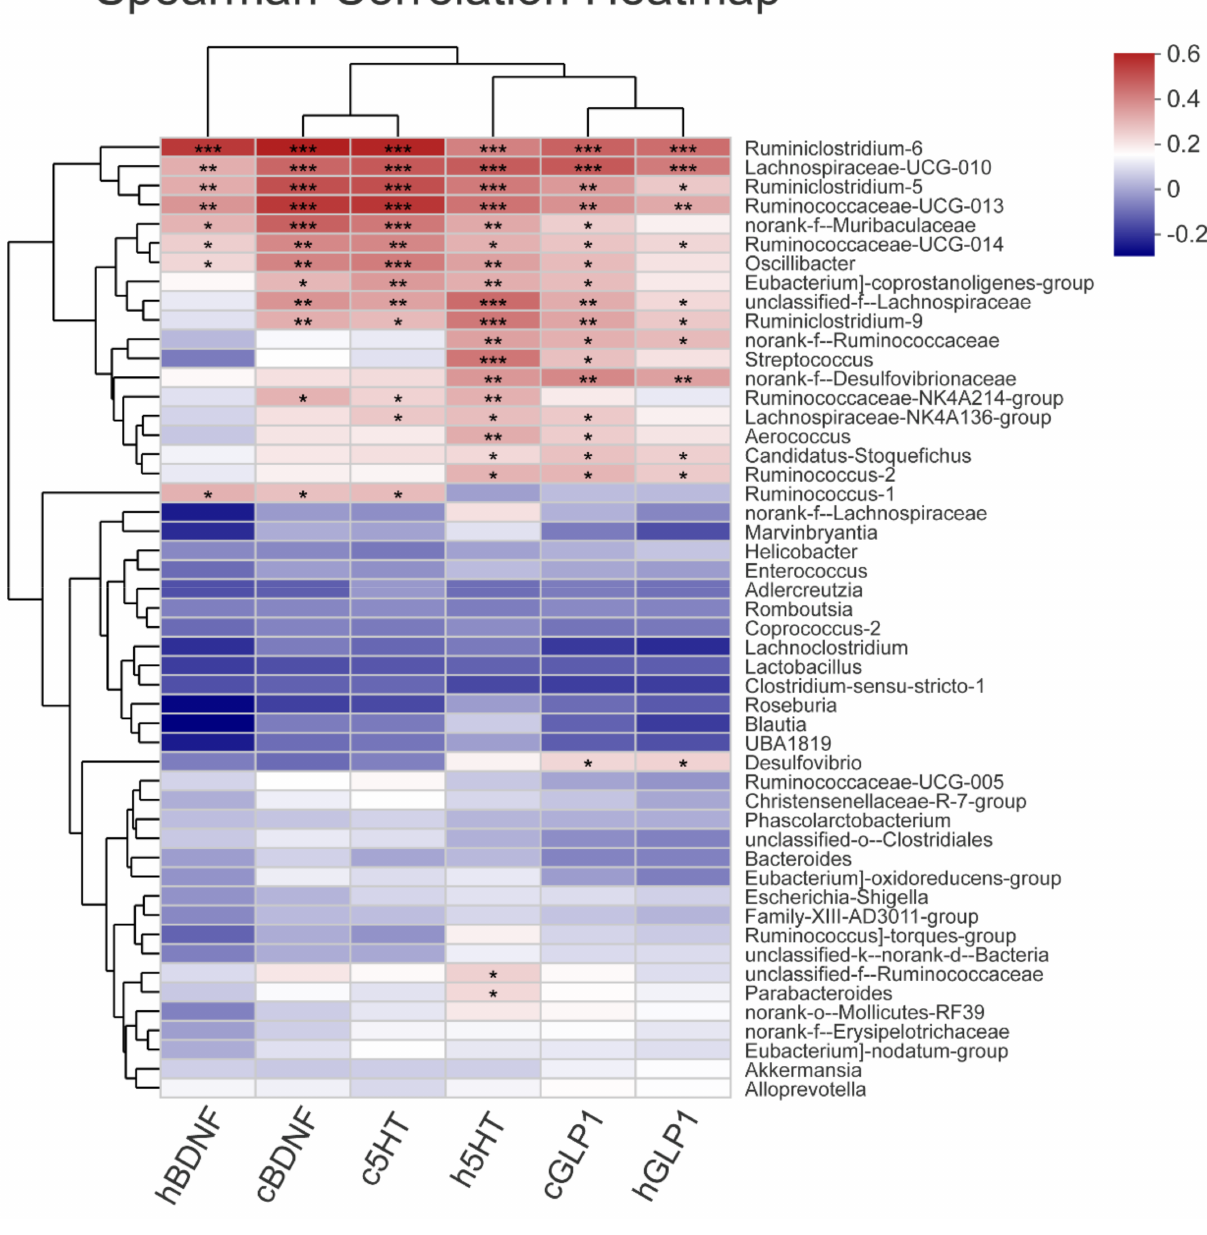
Figure 9. Correlations between the abundances of genera and neurotransmitters in CUMS rats. The heatmap shows Spearman’s rank correlation between neurotransmitters and the relative abundances of the selected genus. The most abundant rat genera with at least one more extreme correlation than − 0.5 or 0.5 are indicated. The asterisk (*) illustrates the statistical significance of the correla- tions between neurotransmitters and the relative abundances of the genera. Hierarchical clustering was presented for both genera and neurotransmitters, based on the Euclidean distances between Spearman’s rank correlations. (* p < 0.05, ** p < 0.01, *** p <